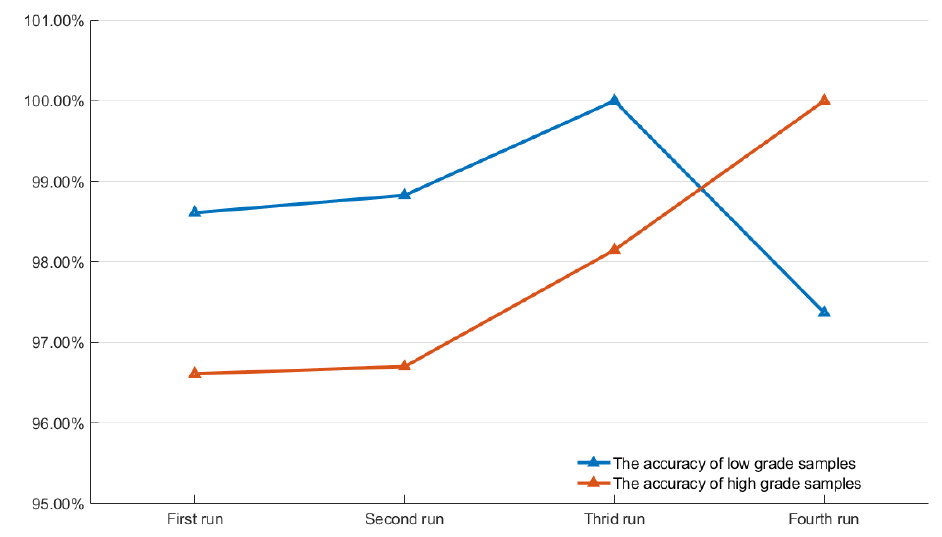
Figure 5. Test set sample accuracy.